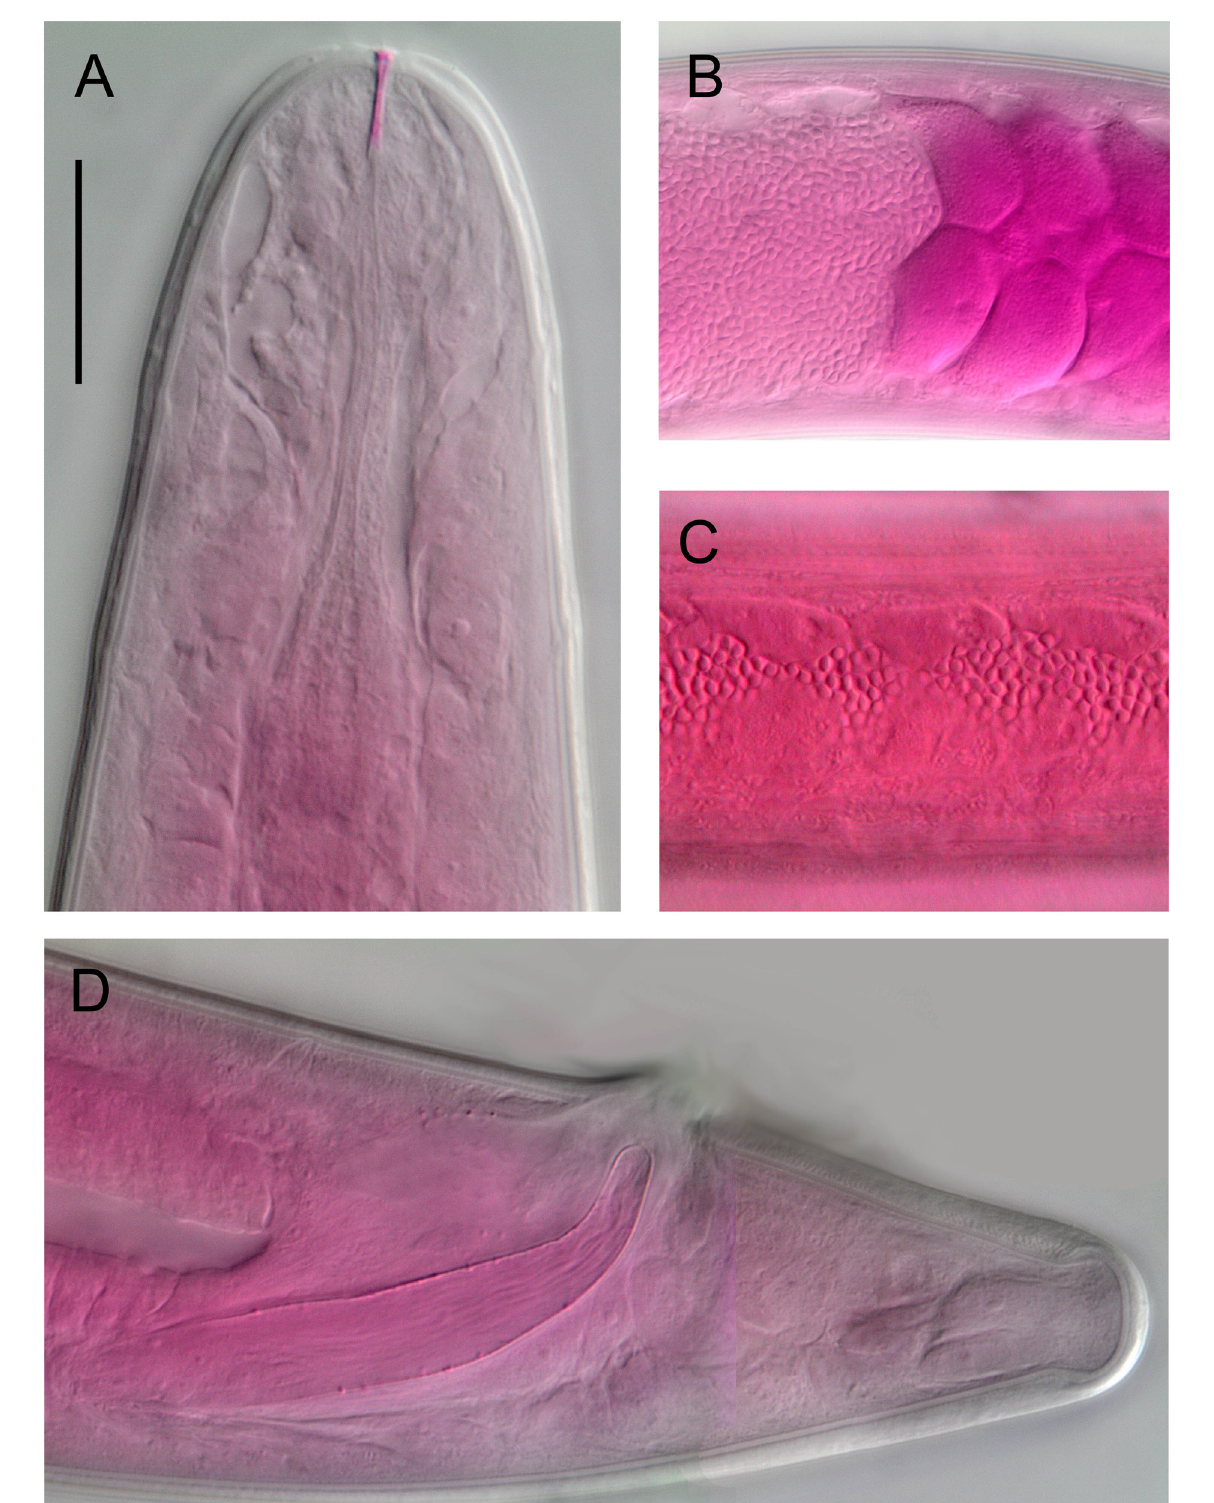
Fig. 3. Rhaptothyreus typicus Hope & Murphy, 1969. Light micrographs (moulting juvenile). A . Lateral view of head, showing stylet-like structure. B . Sharp transition between anterior (left) and posterior trophosome (right). C . Lateral chord, mid-body region. D . Posterior body region. Scale bar: A = 20 µm, B = 40 µm, C = 28 µm, D = 25